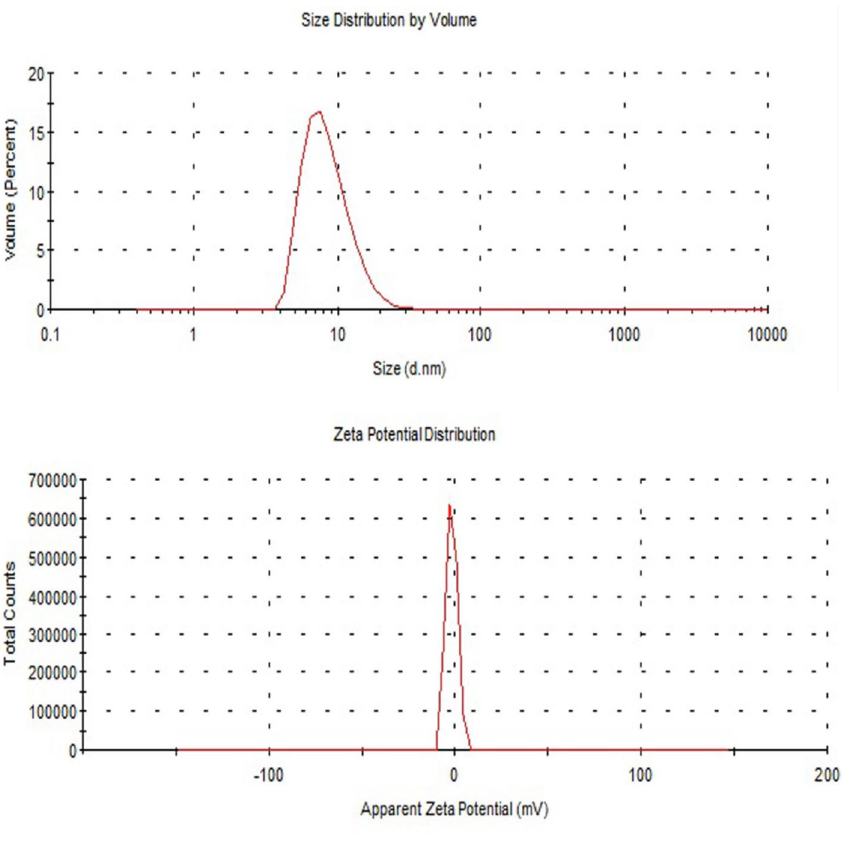
Figure 1. Size distribution and zeta potential distribution of PSO nano-emulsion.